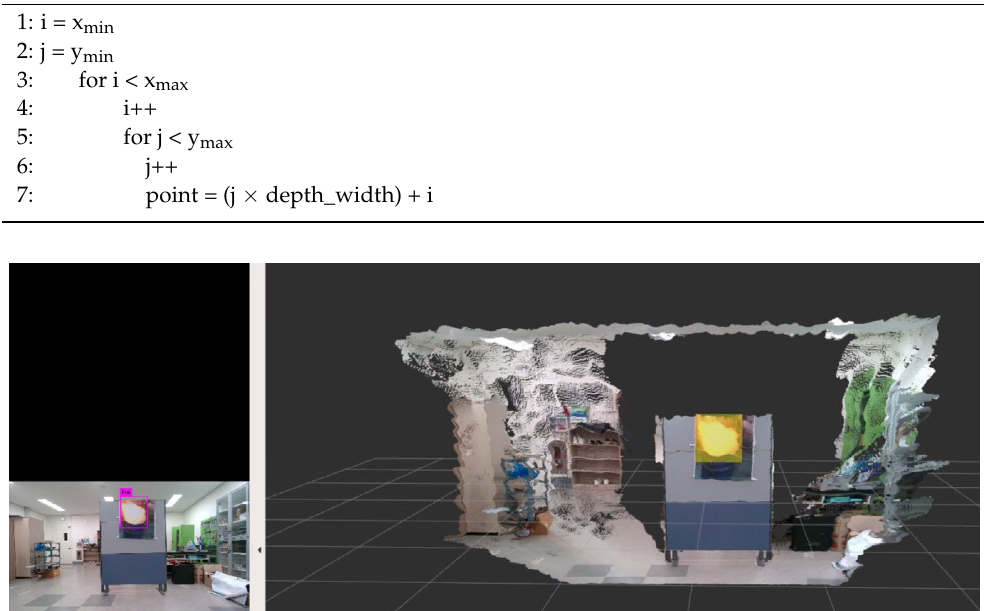
Algorithm 3 Main steps of the coordinate conversion